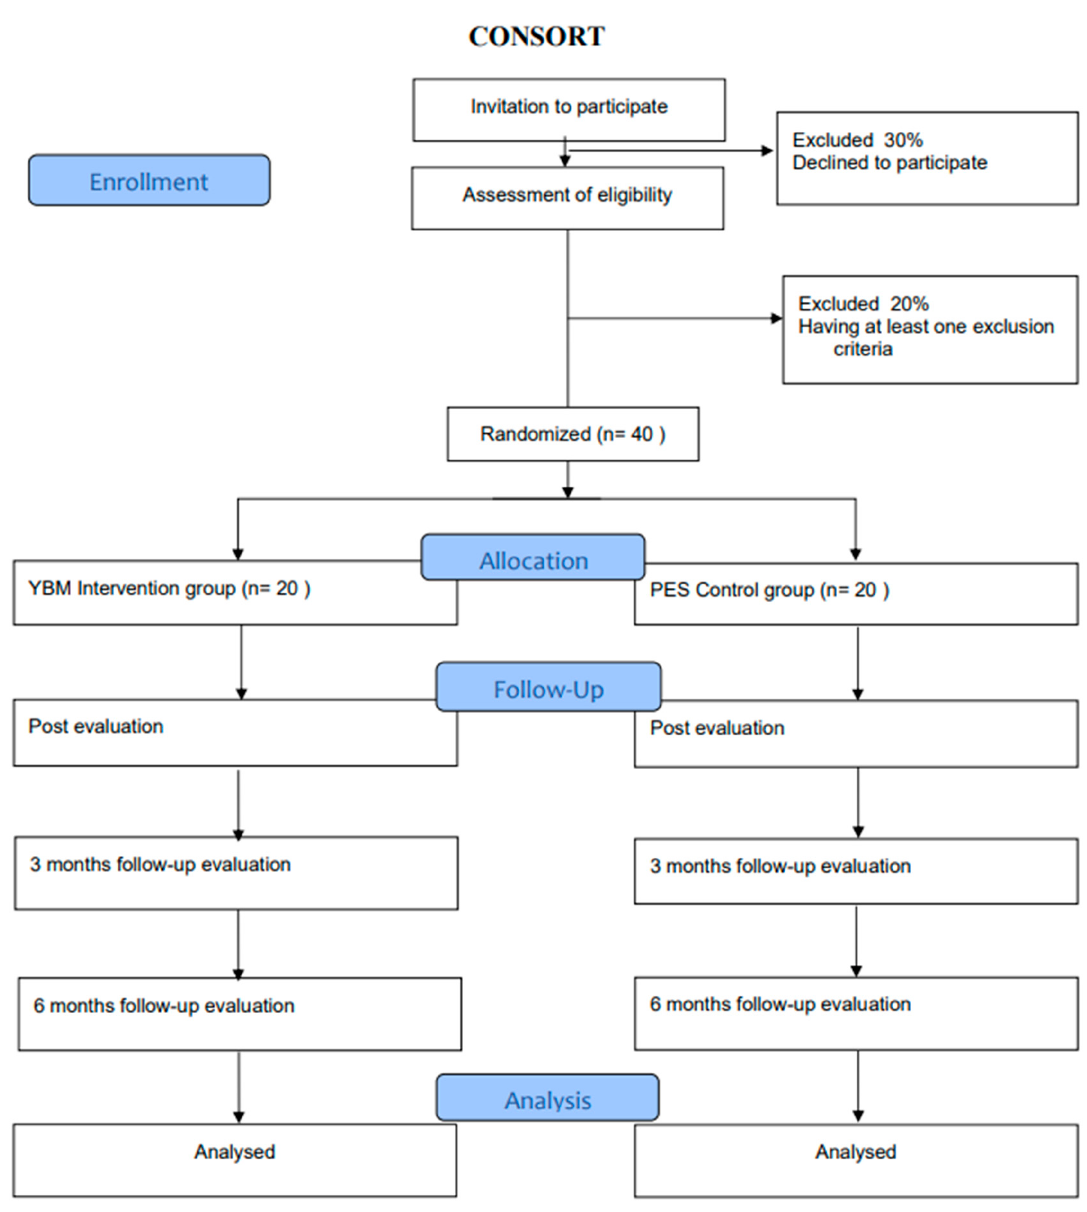
Figure 1. Participant flow through the study.